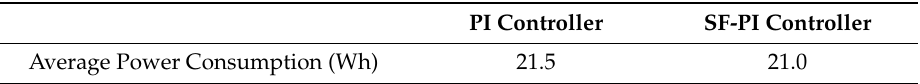
Figure 20. Consumption power comparison for changing temperature and humidity. ( a ) PI Controller. ( b ) SF-PI Controller. Table 11. Average consumption power comparison for changing temperature and humidity.